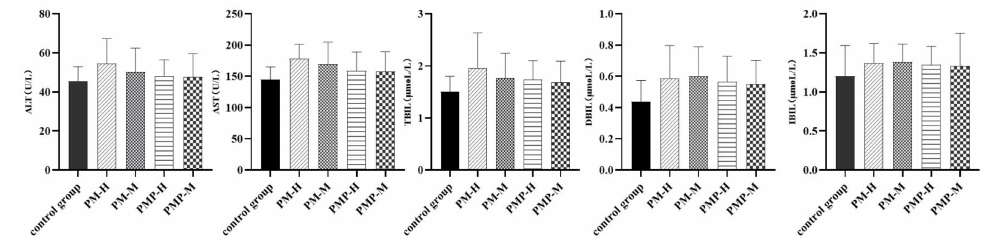
Figure 8. Serum liver function indexes after drug